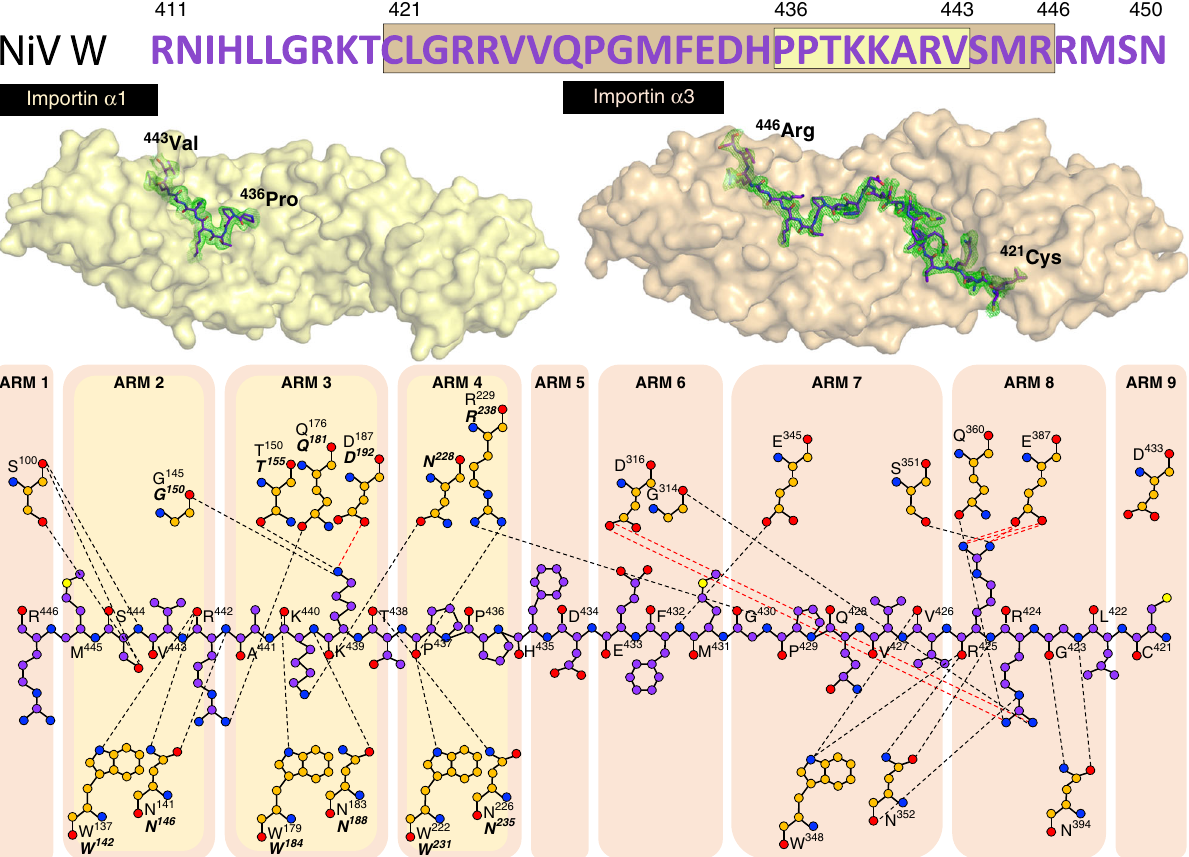
Fig. 3 Structural comparisons and basis for high-af fi nity interaction of NiV W with importin α 3. Importin α 1:NiV W and importin α 3:NiV W structures were solved to 2.1 Å and 2.3 Å resolution, respectively. The importin α adaptors are shown in cartoon and surface representation (importin α 1: bright yellow, importin α 3: light orange) and NiV W NLS in stick representation (magenta: carbon atoms, red: oxygen atoms, blue: nitrogen atoms) with associated simulated annealing Fo-Fc omit maps of the NLSs contoured to 3 σ in green. Schematics of the binding interface and speci fi c interactions are shown below (magenta: carbon atoms, red: oxygen atoms, blue: nitrogen atoms), with hydrogen bond and salt bridge interactions depicted by dash lines (black and red, respectively), and the partner interactions for importin α 1 (bold italics) and importin α 3 coloured as orange: carbon atoms, red: oxygen atoms, blue: nitrogen atoms. The location of these interactions in the ARM repeats highlight the greater interaction interface of the NiV W NLS for the importin α 3